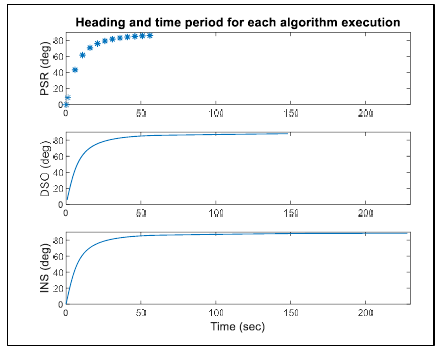
Figure 22. Time period of each algorithm execution on attitude Figure 23 and Figure 24 show the attitude errors of INS and of the integrated system. The errors are reduced in all three angles.